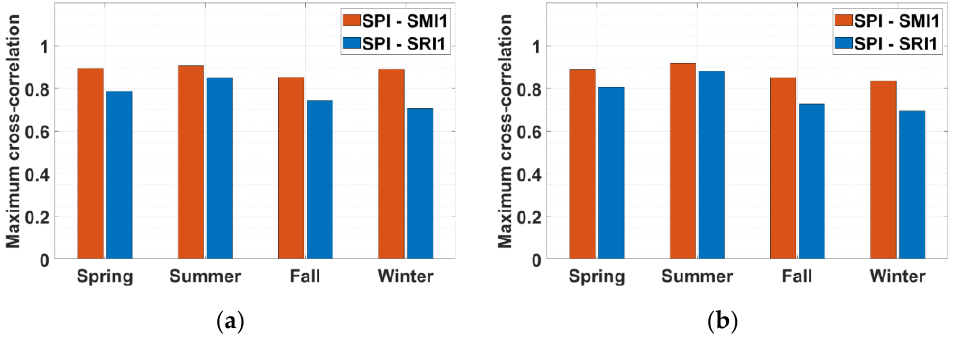
Figure 6. Maximum cross-correlation between SPI-m and SMI-1 (or SRI-1): ( a ) Andong Dam Basin; ( b ) Hapcheon Dam Basin.